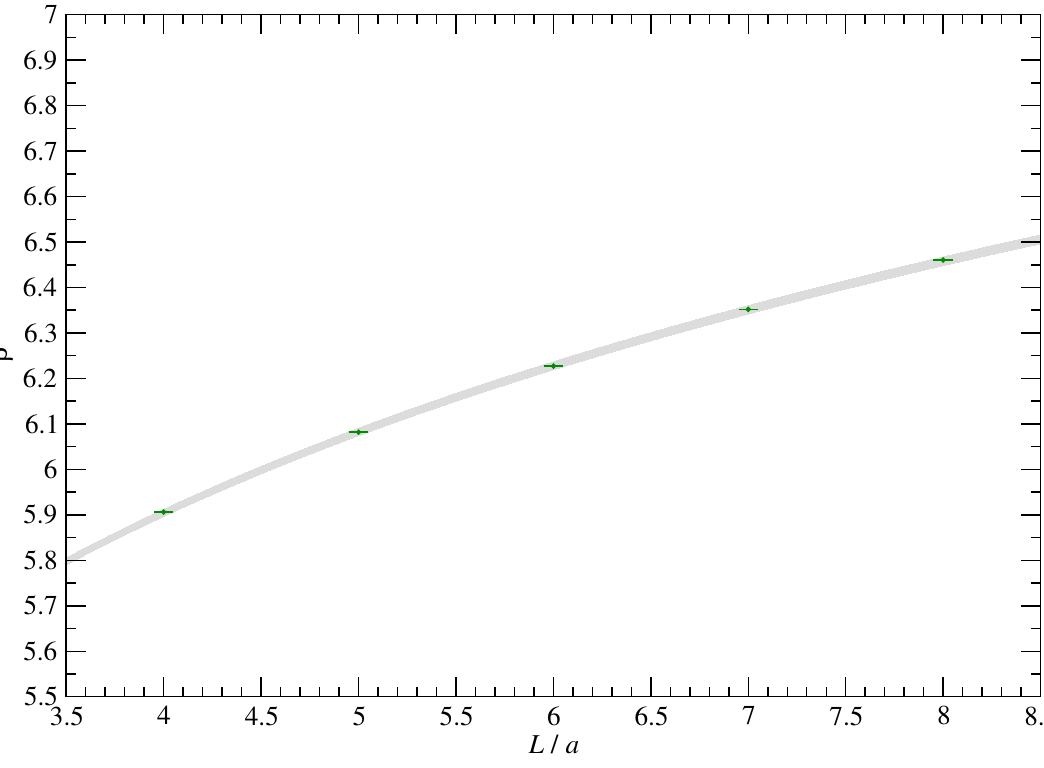
corresponding to g 2 = 3 : 467 0